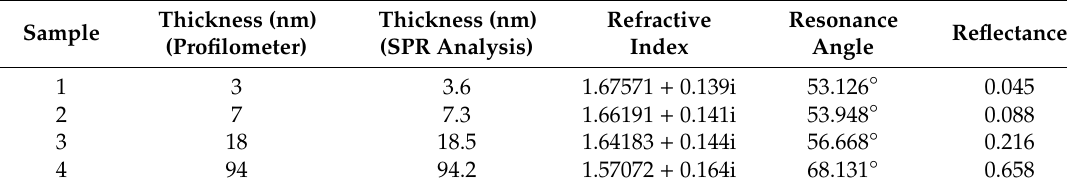
Figure 4. Variation of ( a ) real ( n ) and ( b ) imaginary ( k ) parts of the refractive index of PPy–Chi–BaFe 2 O 4 . Table 1. The thickness, refractive index, resonance angle, and reflectance of SPR signal related to PPy–Chi–BaFe 2 O 4 sensing